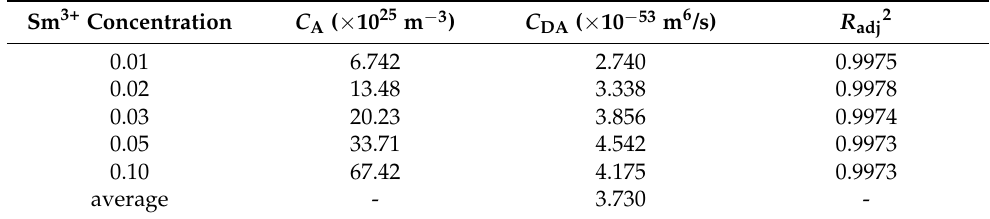
Table 3. Relevant parameters in I-H model analysis.